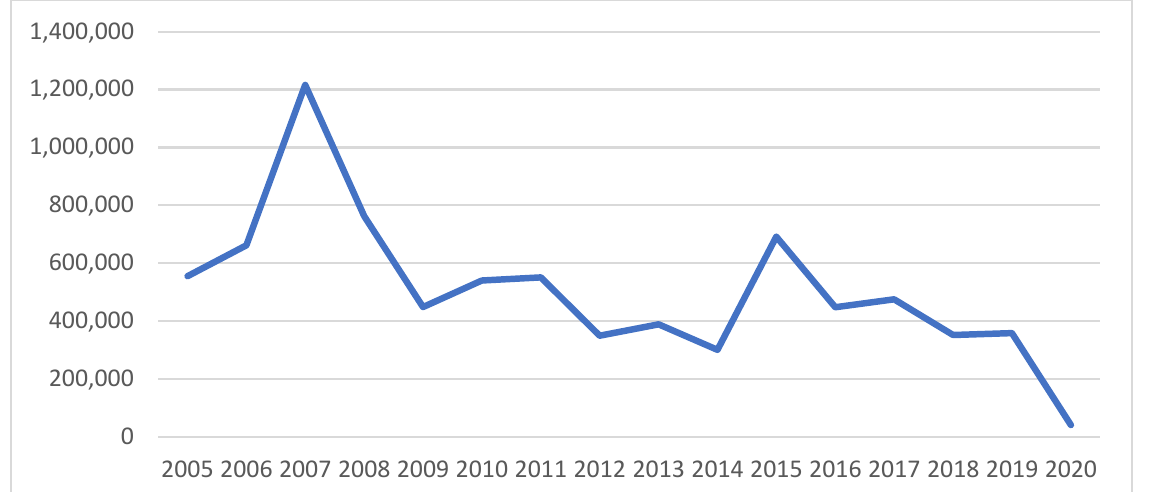
Figure 1. FDI flows outward, EU, million USD, 2005–2020. Source: OECD (2022), FDI flows (indicator). doi:10.1787/99f6e393-en (accessed on 1 February 2022).